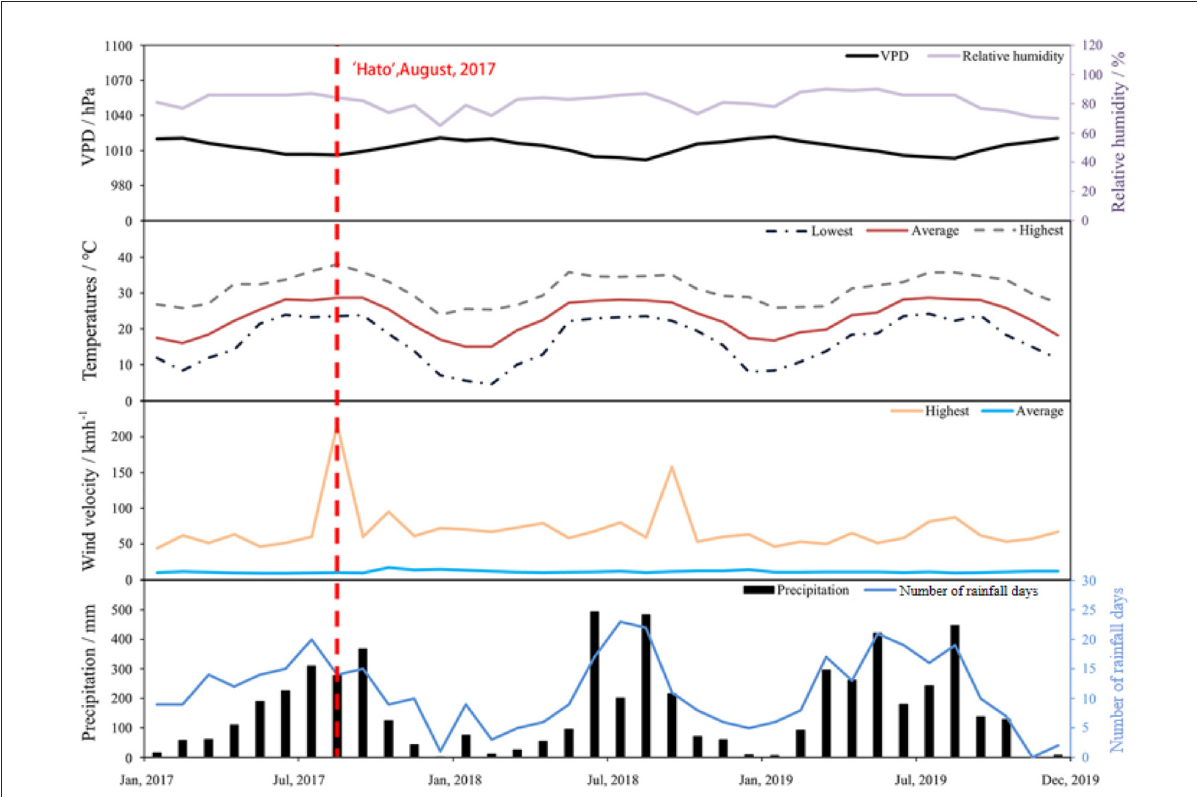
FIGURE2 Monthly climate variables, including highest wind velocities (km h − 1 ), average wind velocities (m s − 1 ), precipitation (mm), number of rainfall days, highest temperature ( ◦ C), mean temperature ( ◦ C), and lowest temperature ( ◦ C) for Zhuhai from January 2017 to December 2019. The vertical-red-dotted line indicates when Typhoon Hato arrived at Zhuhai